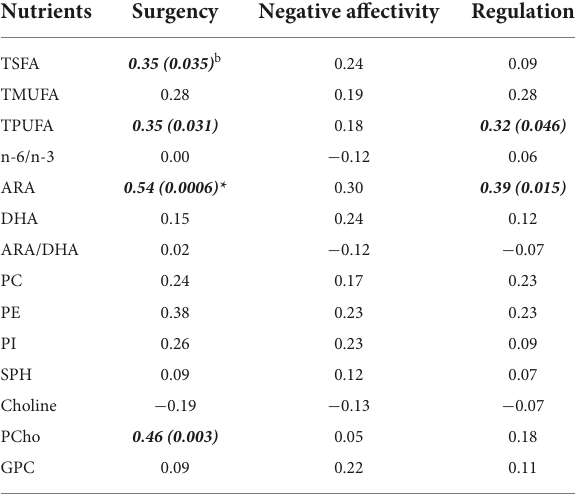
TABLE 4 Standardized regression coefficients of the human milk nutrients with the Infant Behavior Questionnaires—Revised factors. a Nutrients